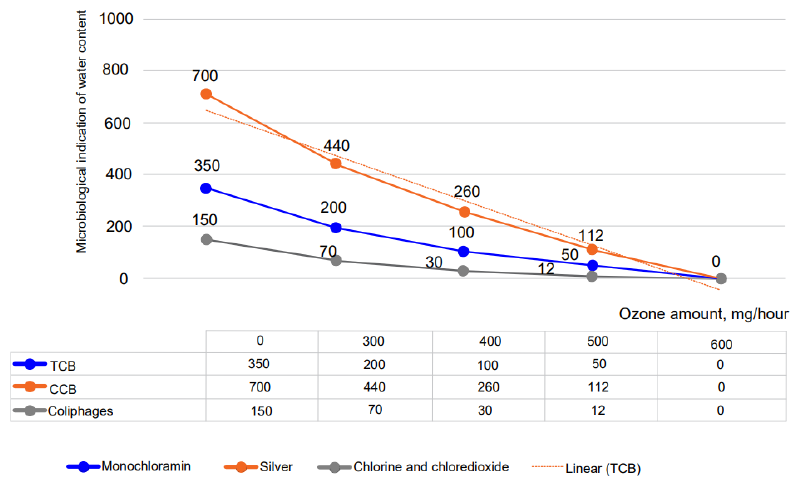
Figure 6. Interaction of water composition with microbiological indicators and ozone dependence.